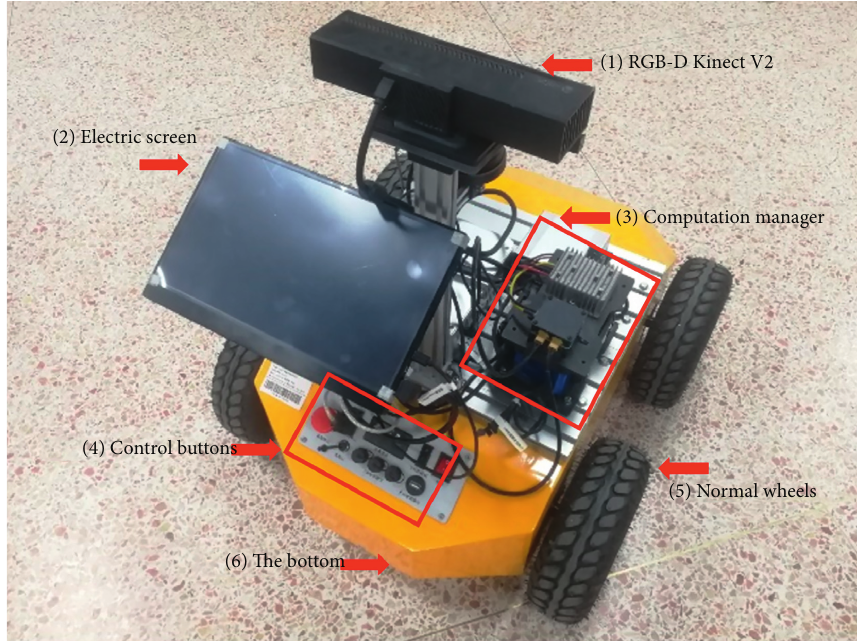
Figure 3: The unmanned car of Autolabor Pro1.